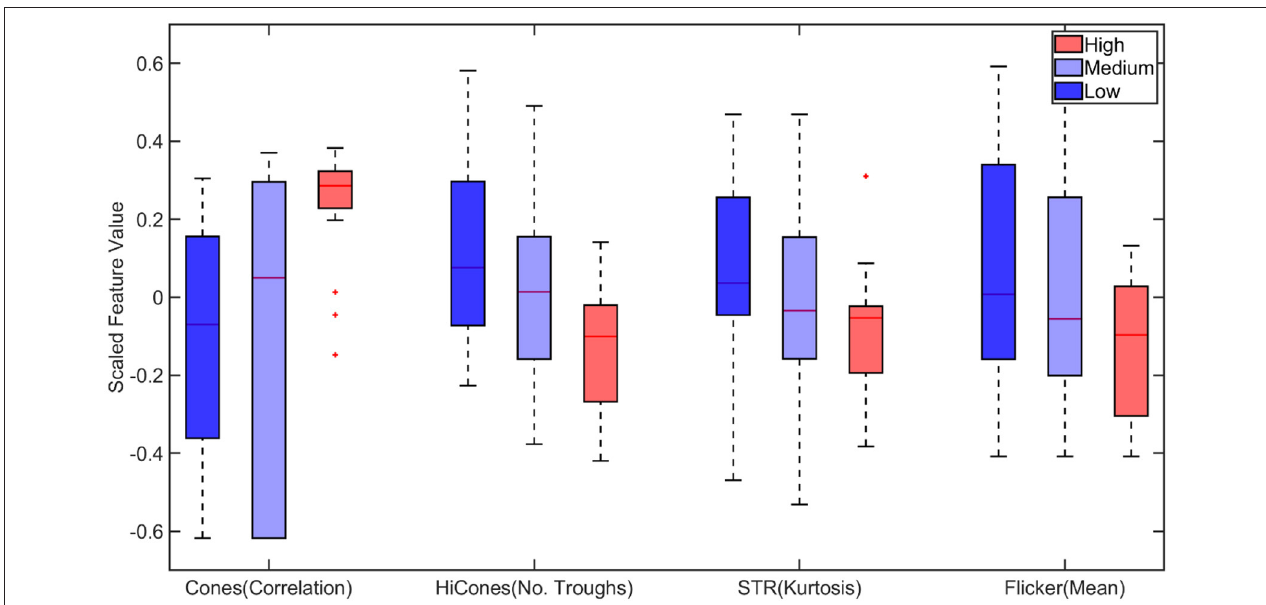
FIGURE 8 | Boxplot of statistical features selected by Minimum Redundancy and Maximum Relevance (MRMR) feature selection algorithm for multiclass classification. STR, Scotopic Threshold Response. On each box, the central mark corresponds to the median, and the bottom and top edges of the box correspond to the 25th and 75th percentiles, respectively. The dashed lines (whiskers) extend to the most extreme data points not considered outliers, and the outliers are plotted individually using the “+” marker symbol.